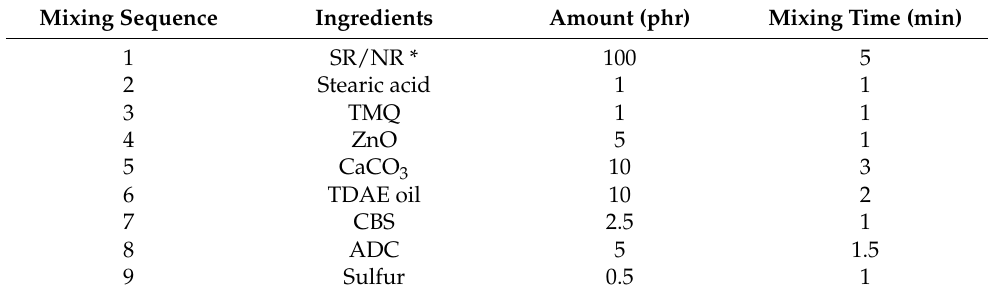
Table 2. Mixing sequence and compounding ingredients used for preparing the rubber